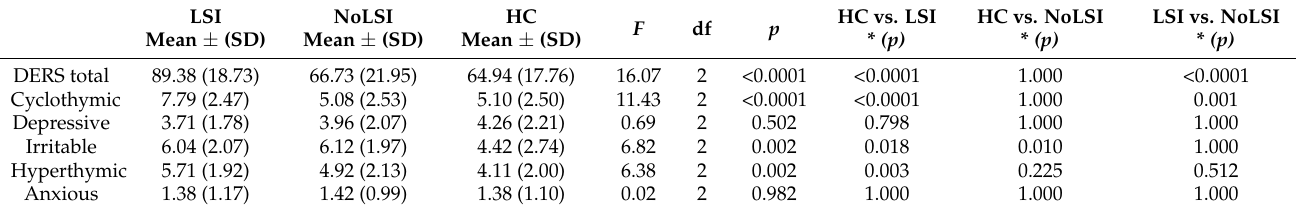
Table 2. Distribution patterns of emotional dysregulation and TEMPS-A-39 affective temperaments in LSI (N = 24), NoLSI (N = 26) and HC (N =